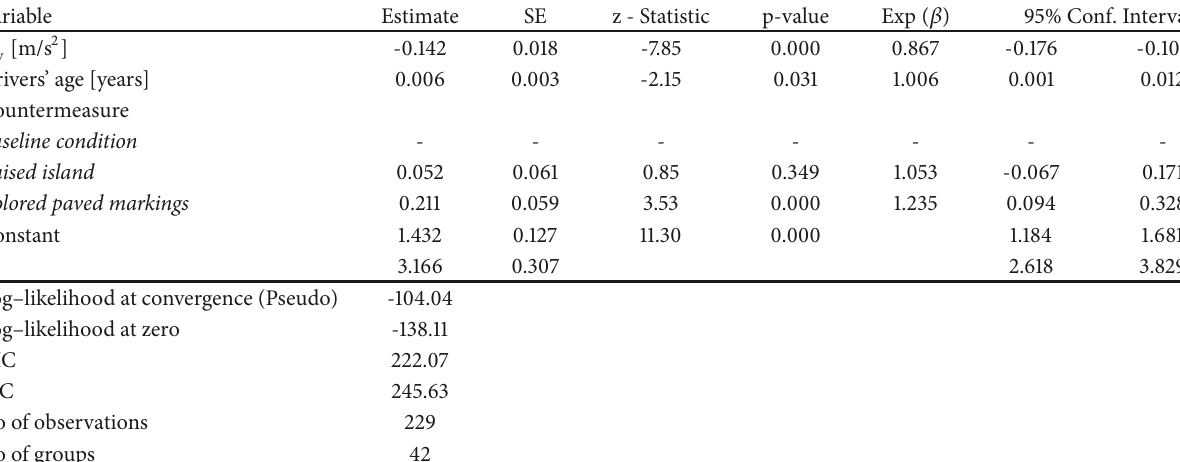
Table 5: Estimates of the Weibull AFT model with clustered heterogeneity for